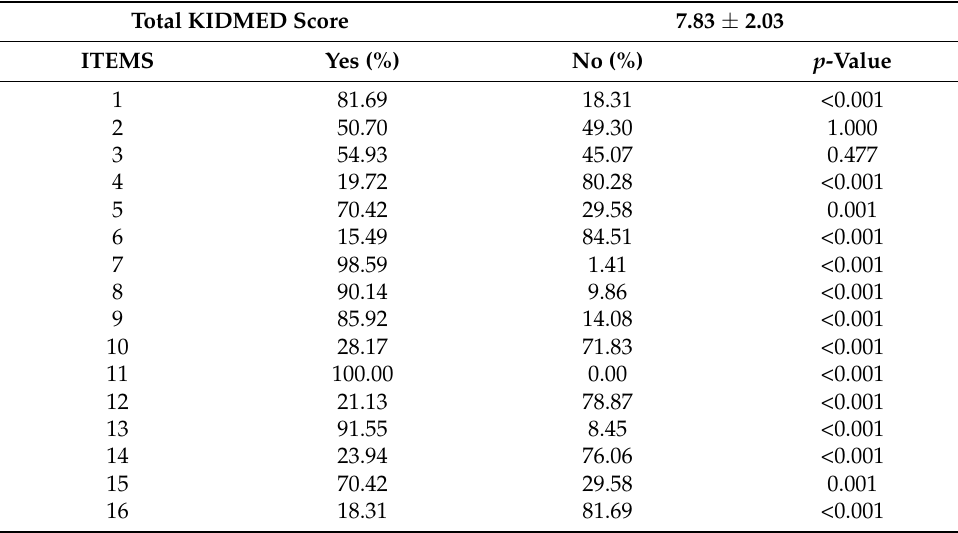
Table 4. Mediterranean diet quality index statistics for total sample.